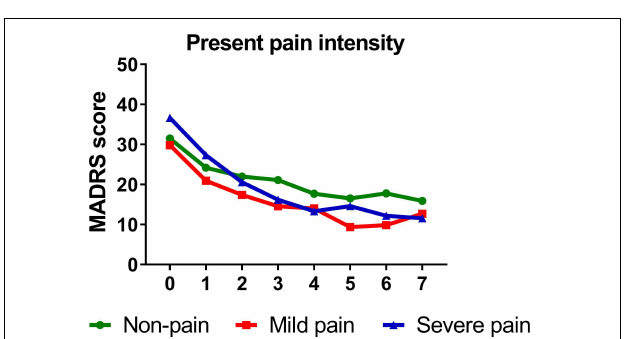
FIGURE 3 | Overall change in MADRS score across six infusions. Pain severity was defined by sensory index. Patients exhibiting no pain symptom were characterized as “non-pain,” patients exhibiting the mean or below the mean sensory index were characterized as “mild pain” and patients exhibiting above the mean sensory index were characterized as “severe pain.” MADRS, Montgomery-Åsberg Depression Rating Scale. Numbers on X -axis: 0 represents baseline, 1 ∼ 6 represent the next morning after each infusion, 7 represents 2 weeks after infusions (Day 26).